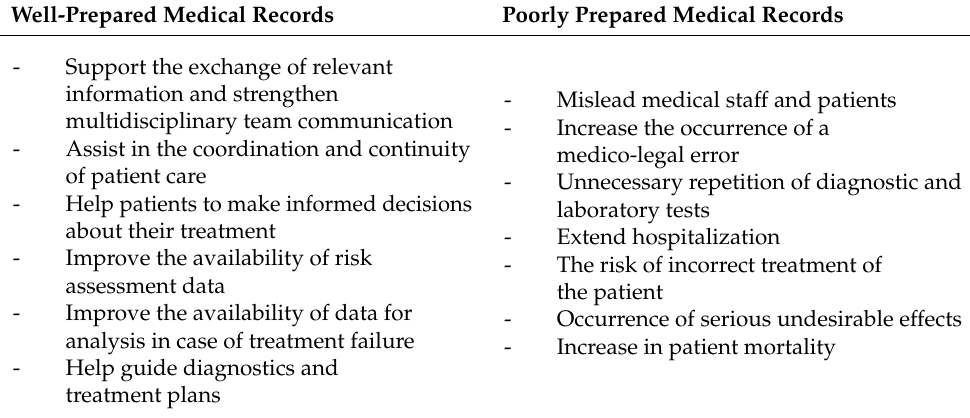
Table 1. Advantages and disadvantages of good and poor medical records